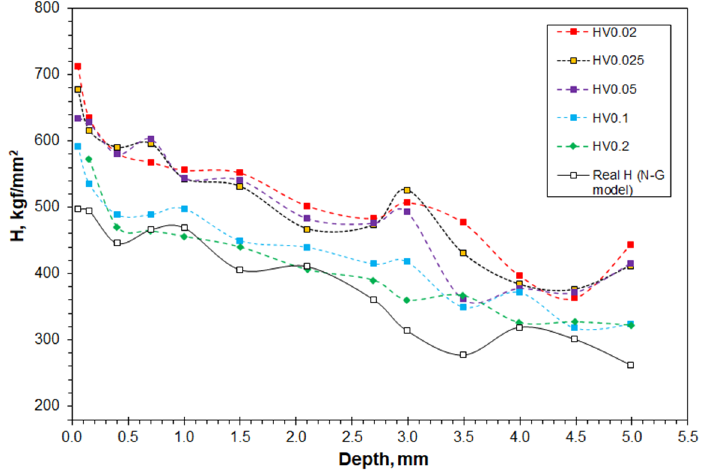
Figure 12. Depth profiles of microhardness and real hardness of the worn Hadfield steel turnout.